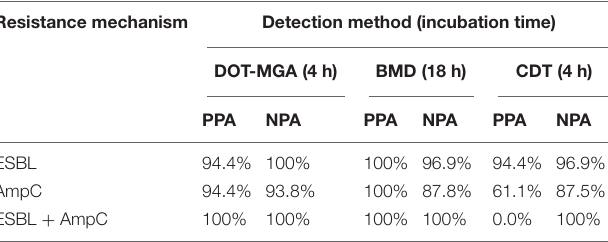
TABLE 2 | Detection performance of DOT-MGA, BMD, and CDT on clinical isolates compared to